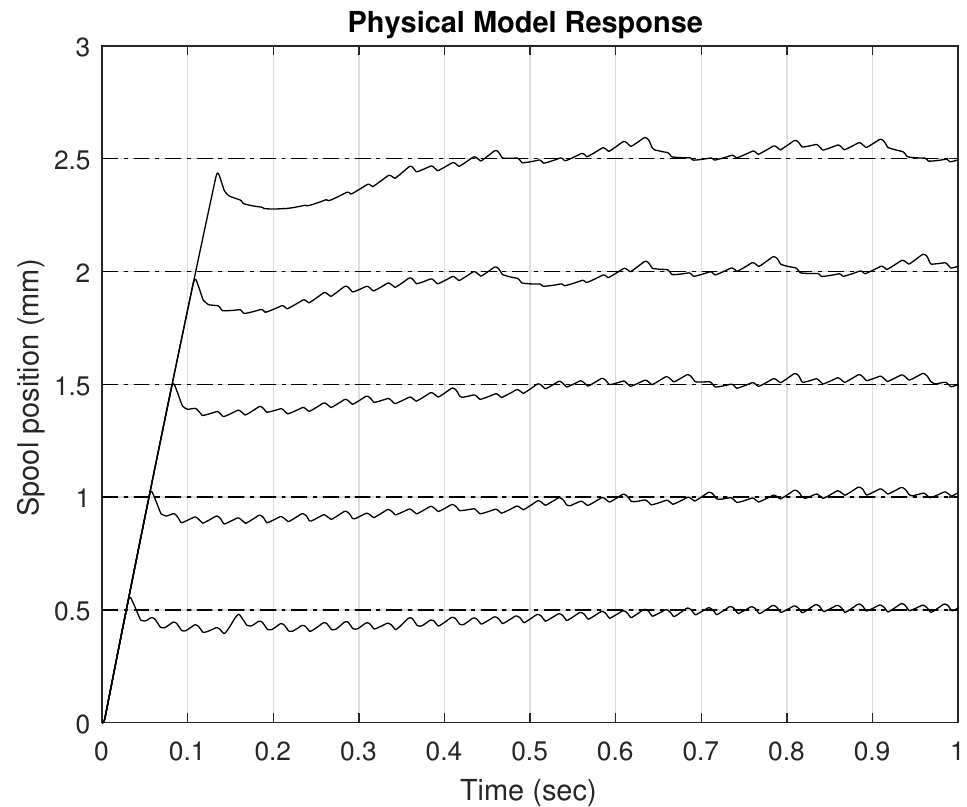
Figure 15. Spool position with the modified